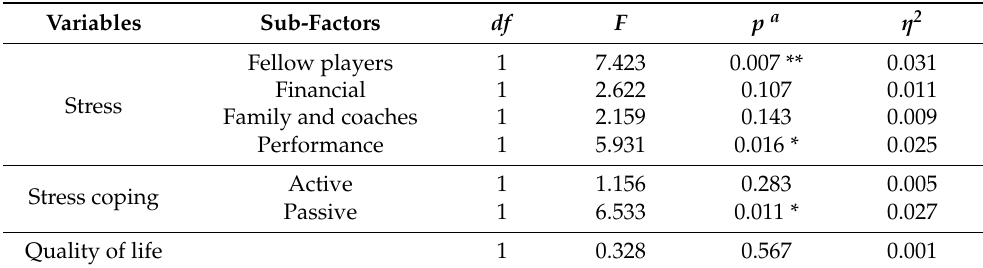
Table 4. Results of MANOVA.